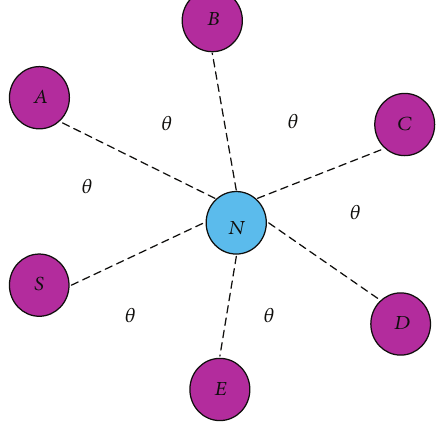
Figure 4: Next hop neighbor angle.